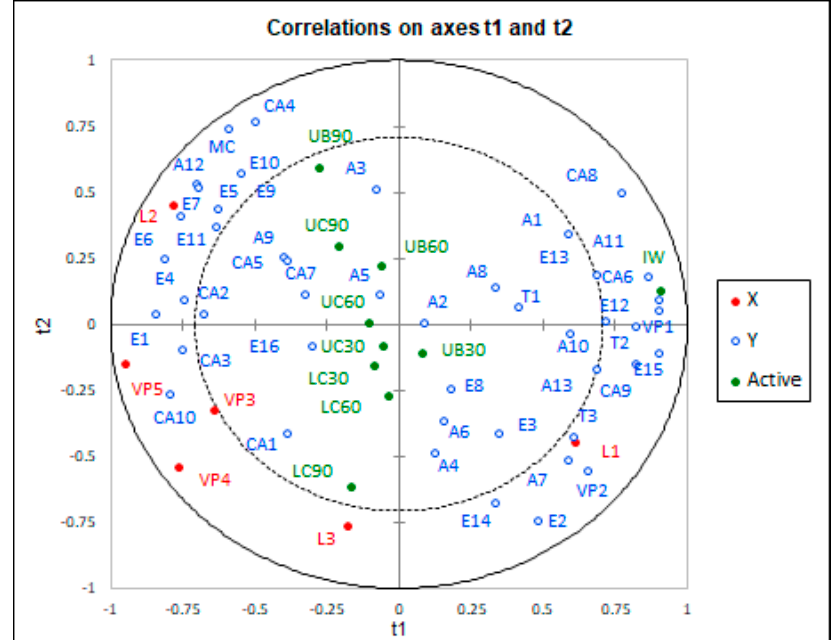
Figure 1. Partial least squares regression (PLSR) analysis, chemical data and the correlation of Muscat Ottonel wines between ageing method and period (t1, chemical components of initial wine; t2, chemical components released from wood). IW, UC30, UC60, UC90, LC30, LC60, LC90, UB30, UB60 and UB90 are the abbreviations for 10 wines of Muscat Ottonel (IW—initial wine,